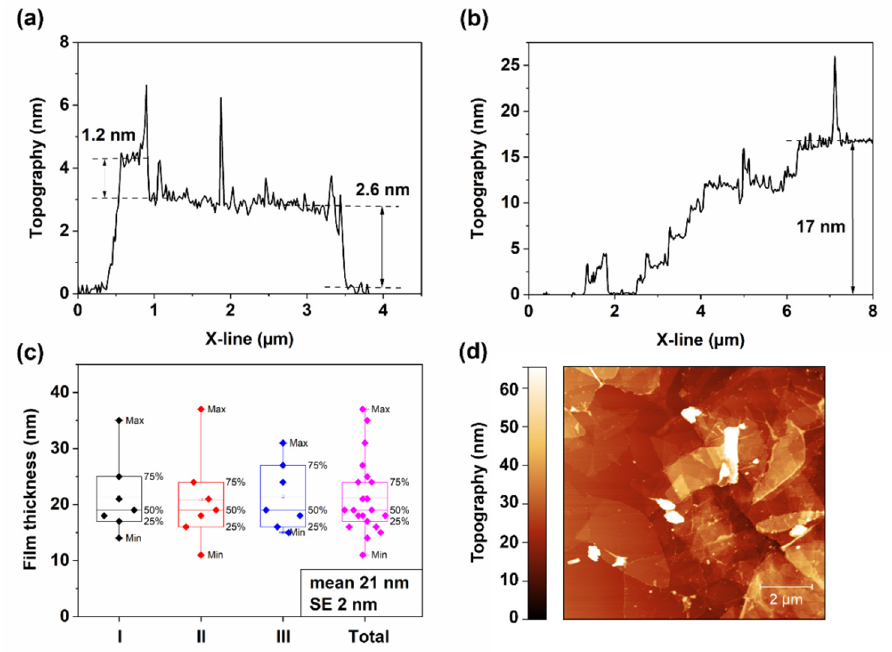
Figure 2. Atomic force microscopy analysis: ( a ) thickness measurement of delaminated single-layered and double-layered Ti 3 C 2 T z MXene flakes; ( b ) 3-layer MXene coating thickness; ( c ) statistical thickness analysis of the coating; ( d ) topographical map of 3-layer MXene coating (close to scratch).